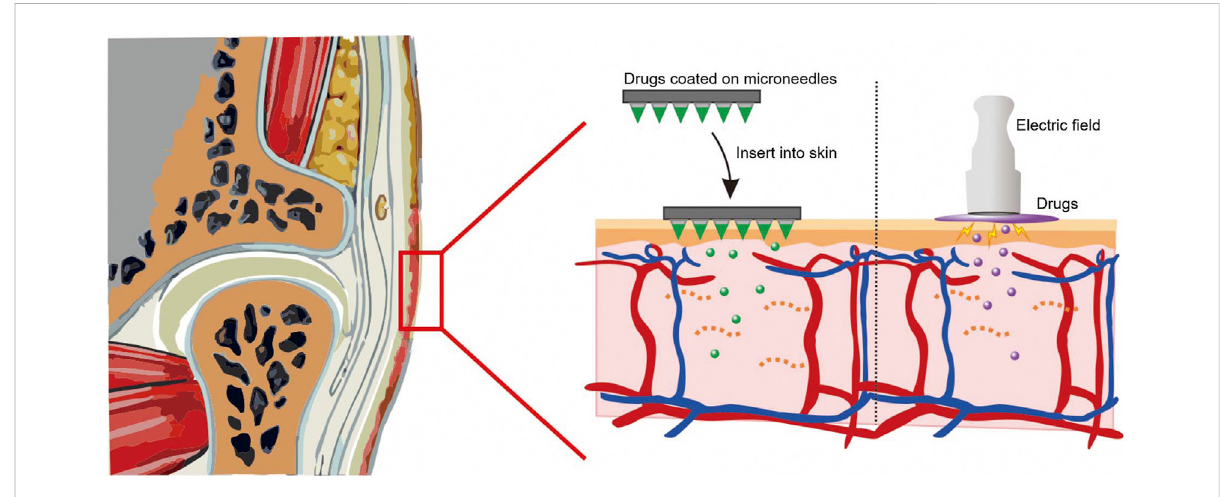
FIGURE 2 Physical techniques of transdermal drug delivery for